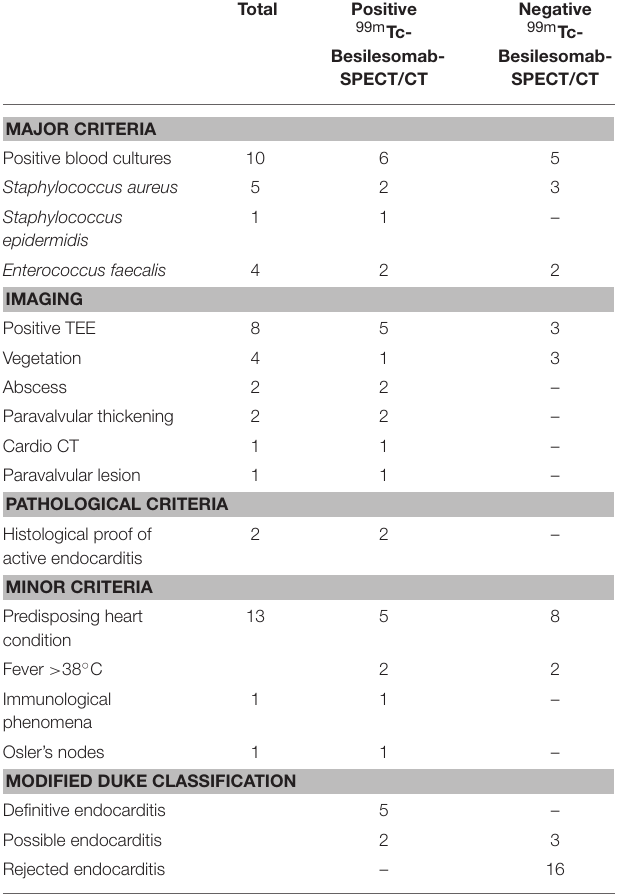
TABLE 2 | Modified duke